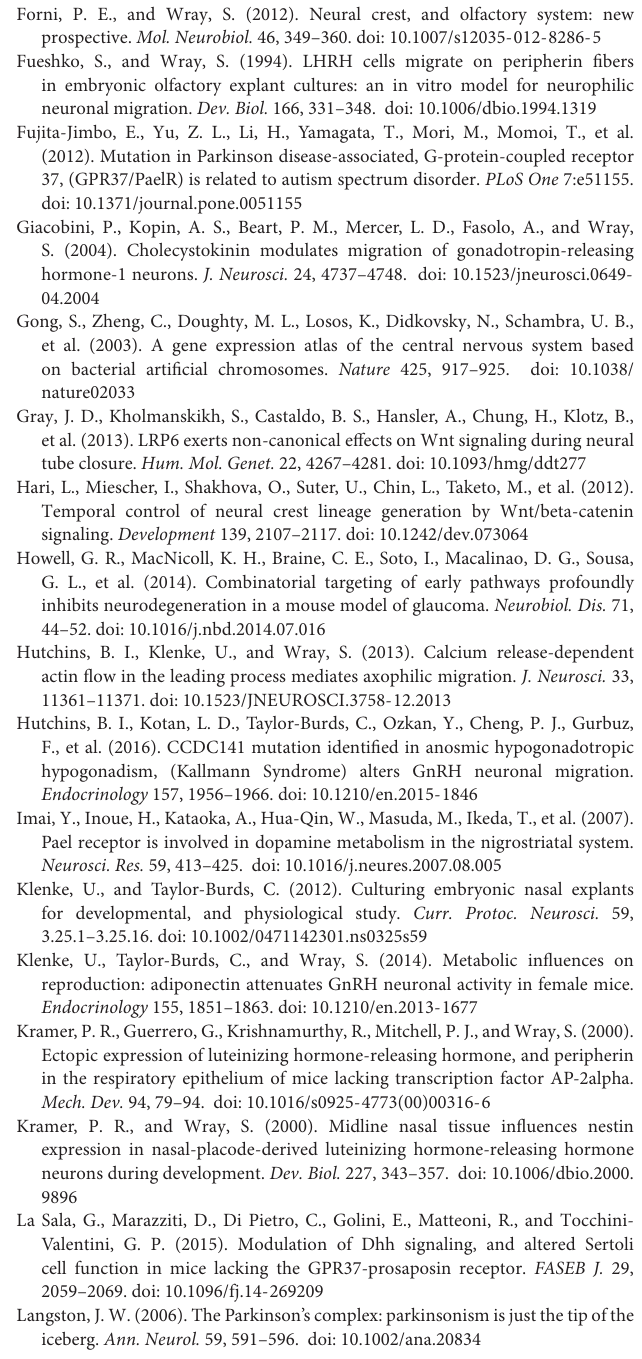
of dense fibers and cells (see B right panel). However, peripherin fibers (white arrow) and GPR37 fibers (black arrows) are not double-labeled. False positive can occur as shown in (B) . Left panel shows image of peripherin fiber (green) coursing over a GnRH cell (red). GnRH cells are not peripherin positive, yet yellow puncta are seen (arrowheads). Right panel shows schematic of the relationship between OECs which are GRP37 positive (green) and GnRH cells which are GPR37 positive (green) and peripherin fibers (red) which are GPR37 negative. As elements sit on each other false positives (orange) can occur. Scale: 10 µ